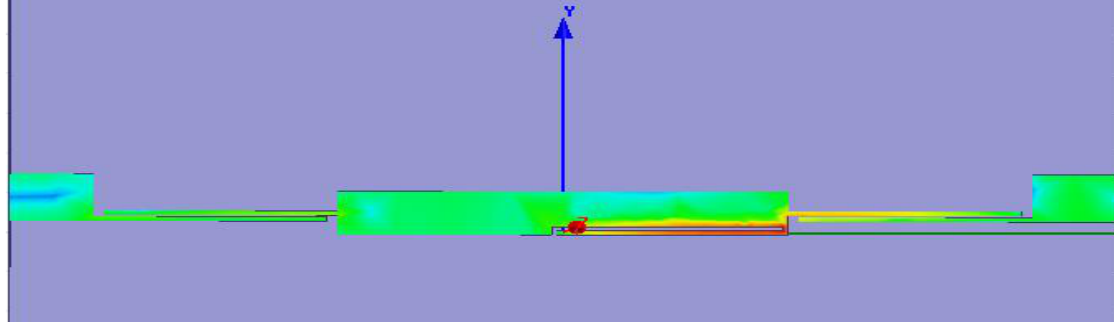
Figure 20. Current distribution of the UWB filter with dual notched band characteristics. This verifies that the proposed structure eliminates the potential interference in ultra- wideband microwave applications and has the advantage of stopping unwanted wireless bands according to the user’s need. In this research work, the novelty is claimed b y using